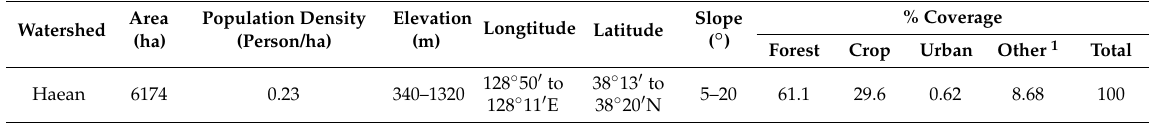
Table 1. Characteristics of the Haean watershed [4,12].